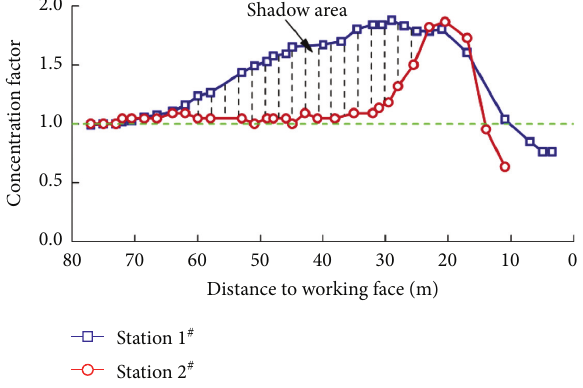
Figure 4: Evolution of advanced abutment